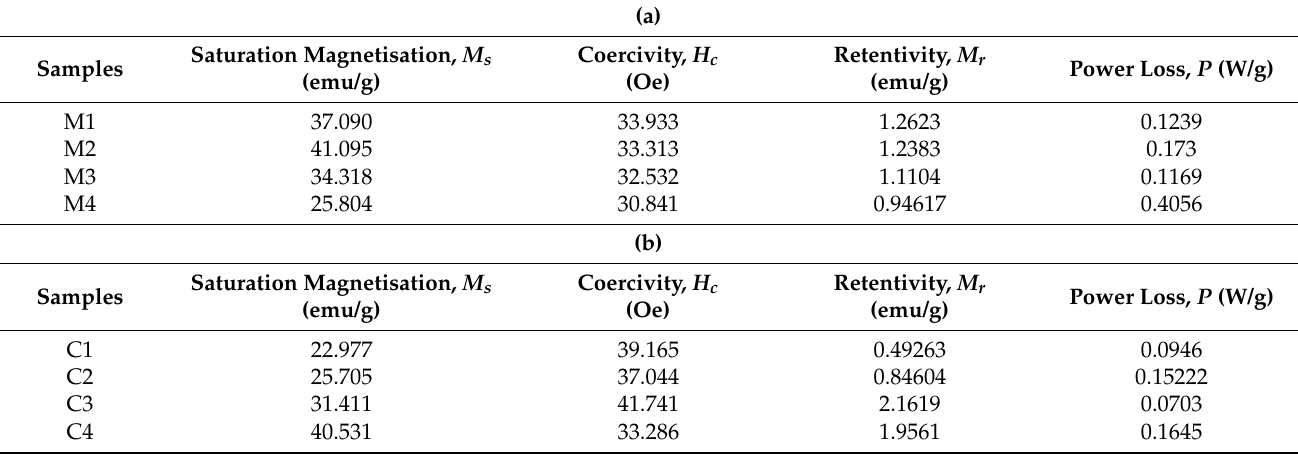
Table 3. ( a ) Magnetic properties and power losses of samples (M1 − M4). ( b ). Magnetic properties and power losses of samples (C1 − C4).